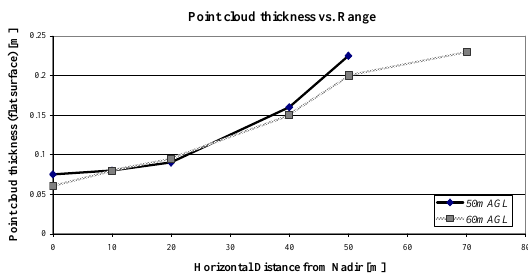
Figure 14: Point cloud thickness (noise) on a flat surface as a function of horizontal distance from nadir at two flying heights.